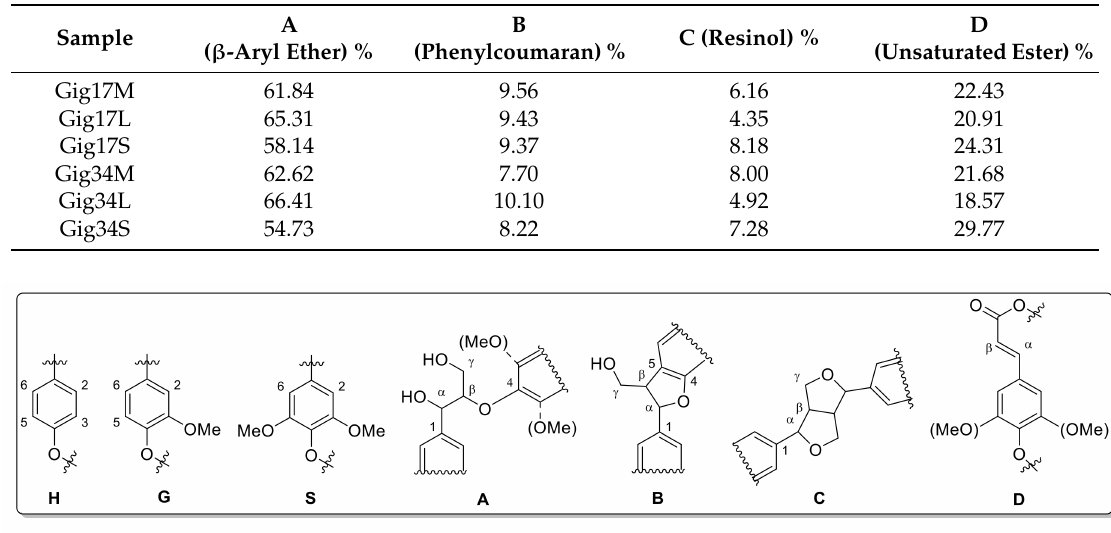
Figure 15. Lignin structure elements for HSQC NMR signal assignment (A: β -O-4 linkage, B: phenylcoumaran, C: resinol, D: β -unsaturated